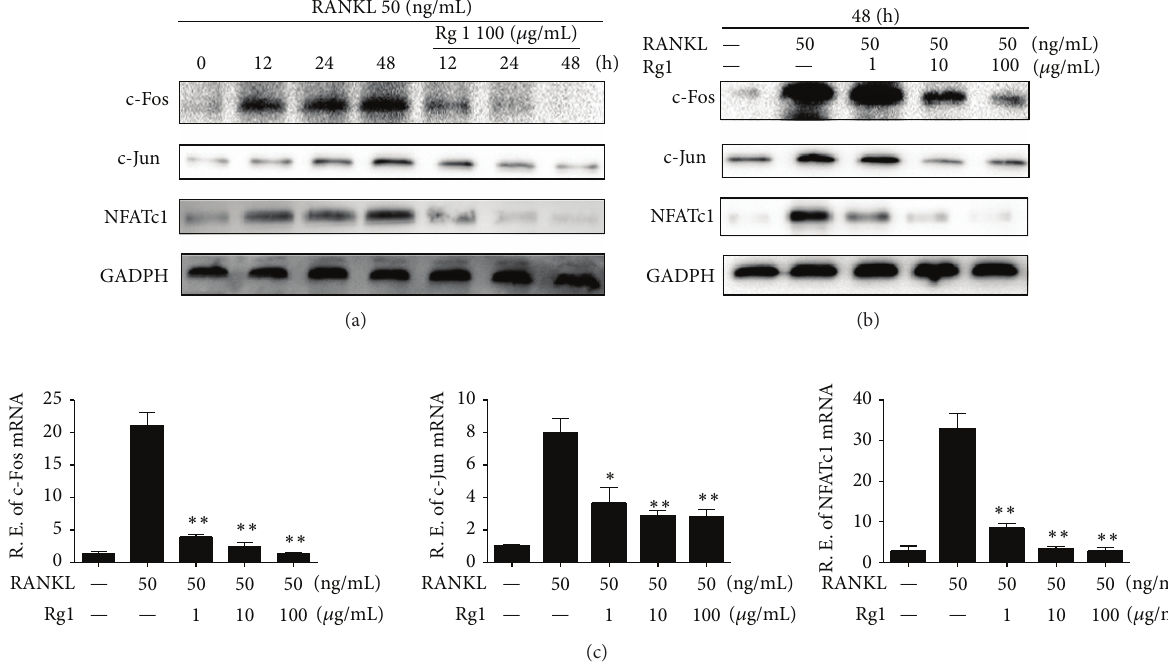
Figure 4: Effect of Rg1 on the RANKL-induced expression of c-Fos, c-Jun, and NFATc1 in RAW 264.7 cells. (a) RAW 264.7 cells (1 × 10 5 cells/mL) were plated in a 6 cm culture plate and cultured with or without RANKL (50ng/mL) and/or Rg1 (100 𝜇 g/mL) for indicated periods. The cell lysates were subjected to Western blot analysis with an antibody to c-Fos, c-Jun, and NFATc1. (b) RAW 264.7 cells (1 × 10 5 cells/mL)wereplatedina6cmcultureplate,andRAW264.7cellswereculturedwithRANKL(50 ng/mL)and/orincreasingconcentrations of Rg1 for 48h. The cells were subjected to Western blot analysis. (c) RAW264.7 cells (2 × 10 4 cells/mL) were cultured with or without RANKL (50 ng/mL) and/or Rg1 (1, 10, and 100 𝜇 g/mL) for 48 h in 12-well plates. The total cellular RNA was extracted and used for RT-PCR analysis to detect c-Fos, c-Jun, and NFATc1 mRNA. All data are representative of three different